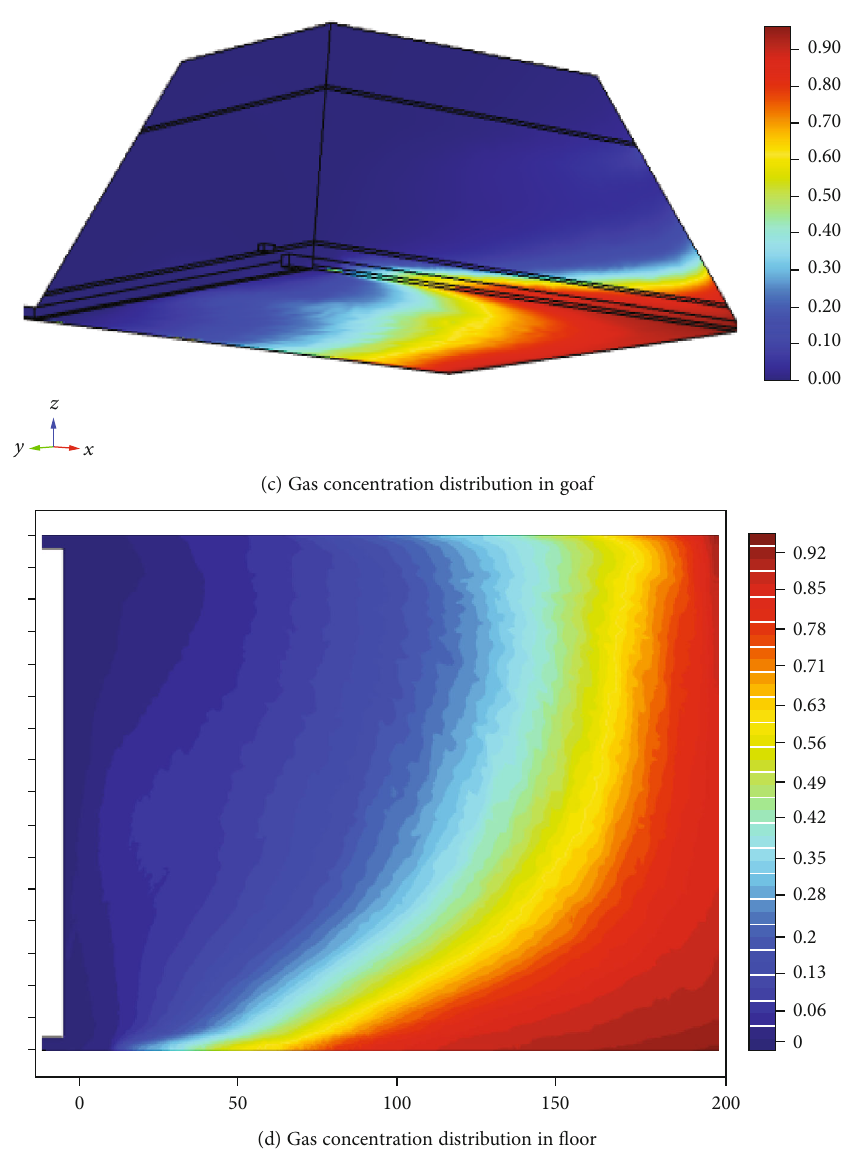
Figure 7: Distribution of fl ow fi eld and concentration fi eld at z = 1 : 5 m of goaf fl